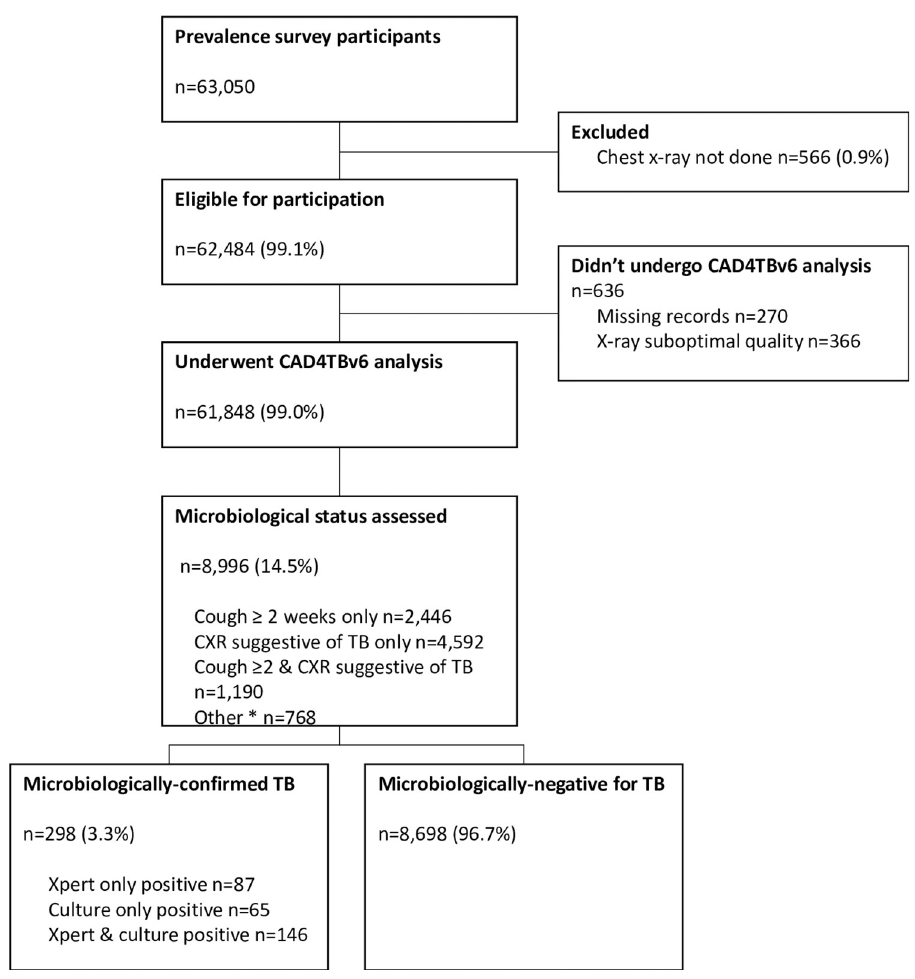
Fig 1. Participant flowchart and results of prevalence survey